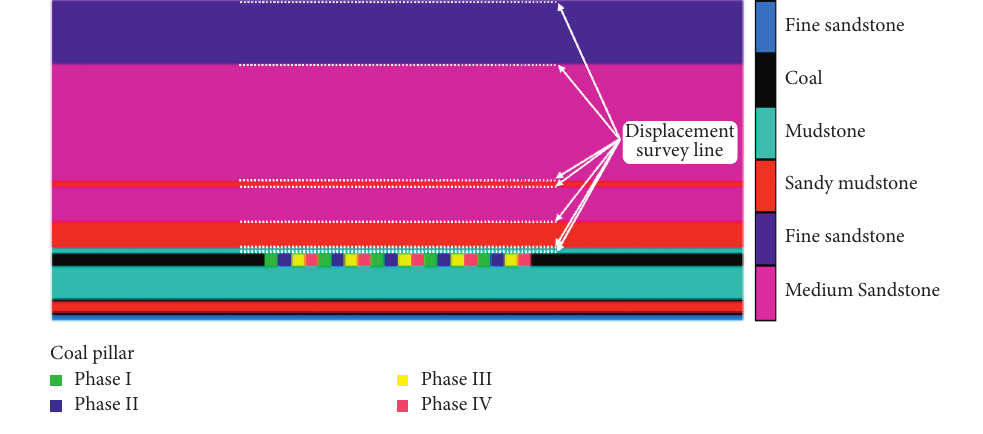
Figure 8: RBM calculation Table 1: Physical and mechanical parameters of each rock formation.